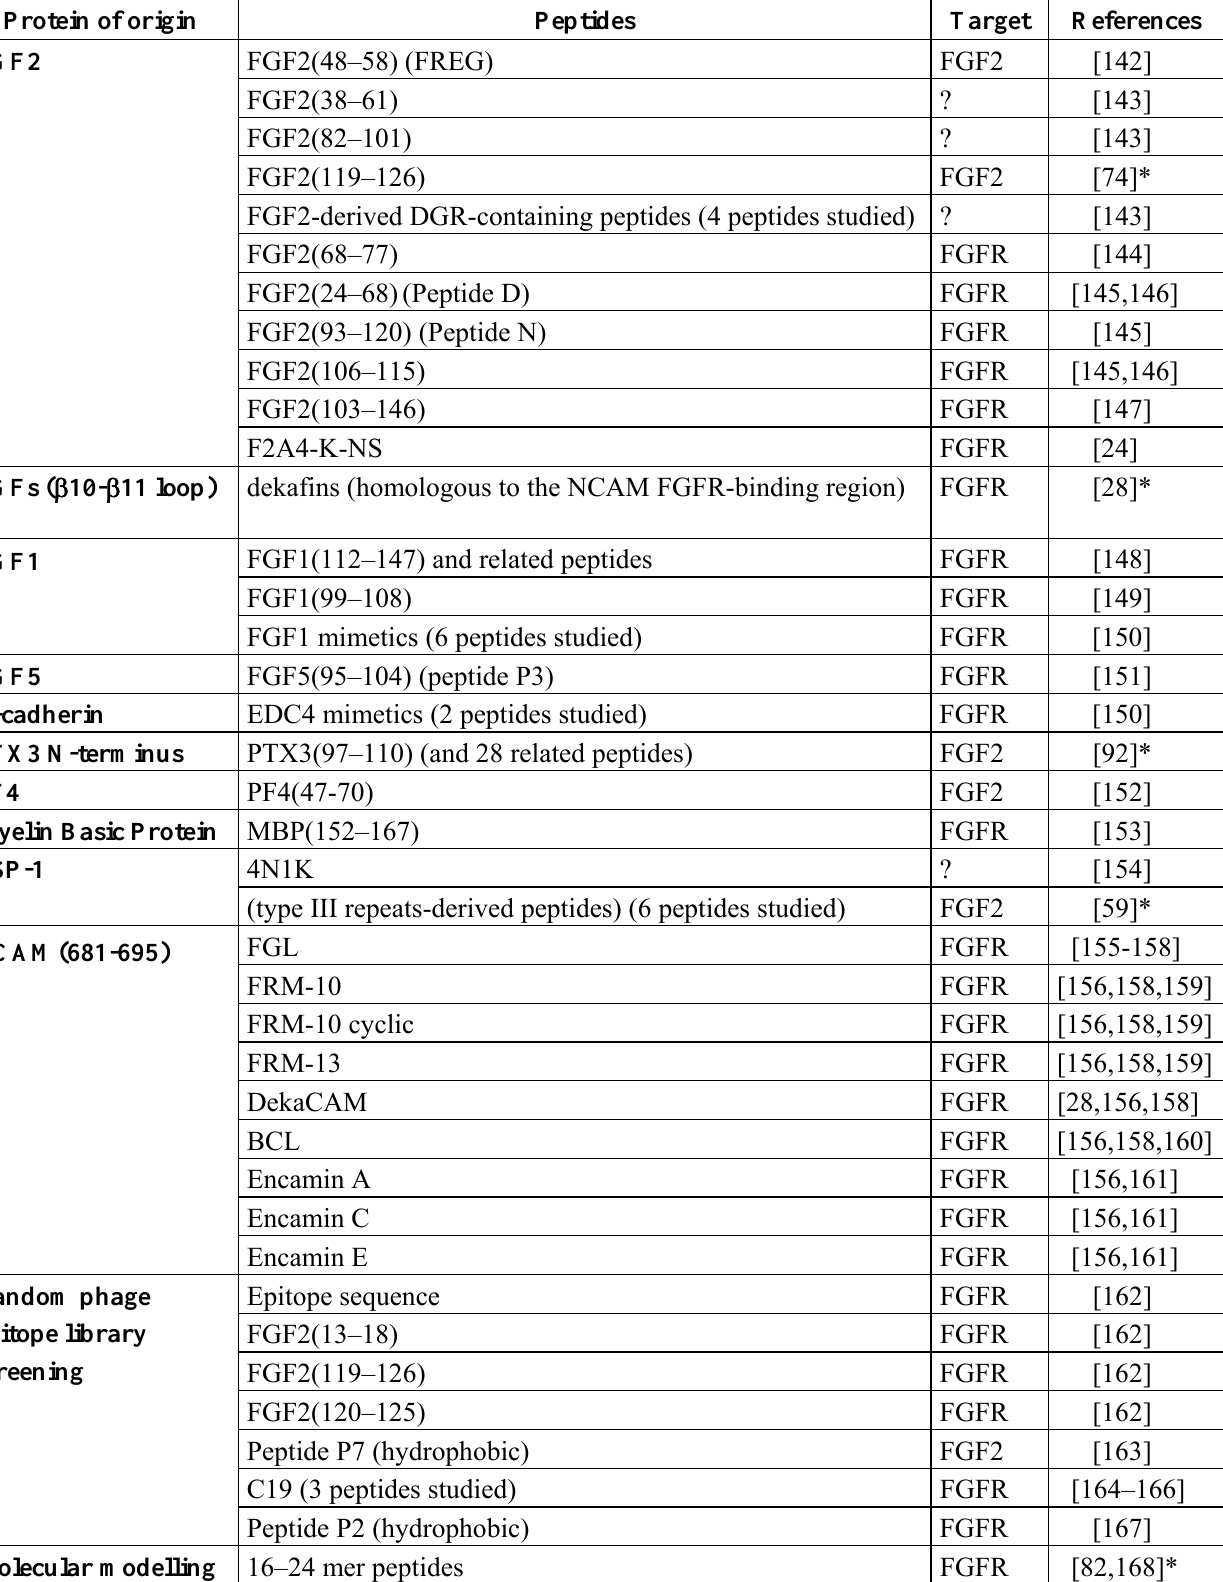
Table 4. Synthetic peptides endowed with FGF2-antagonist